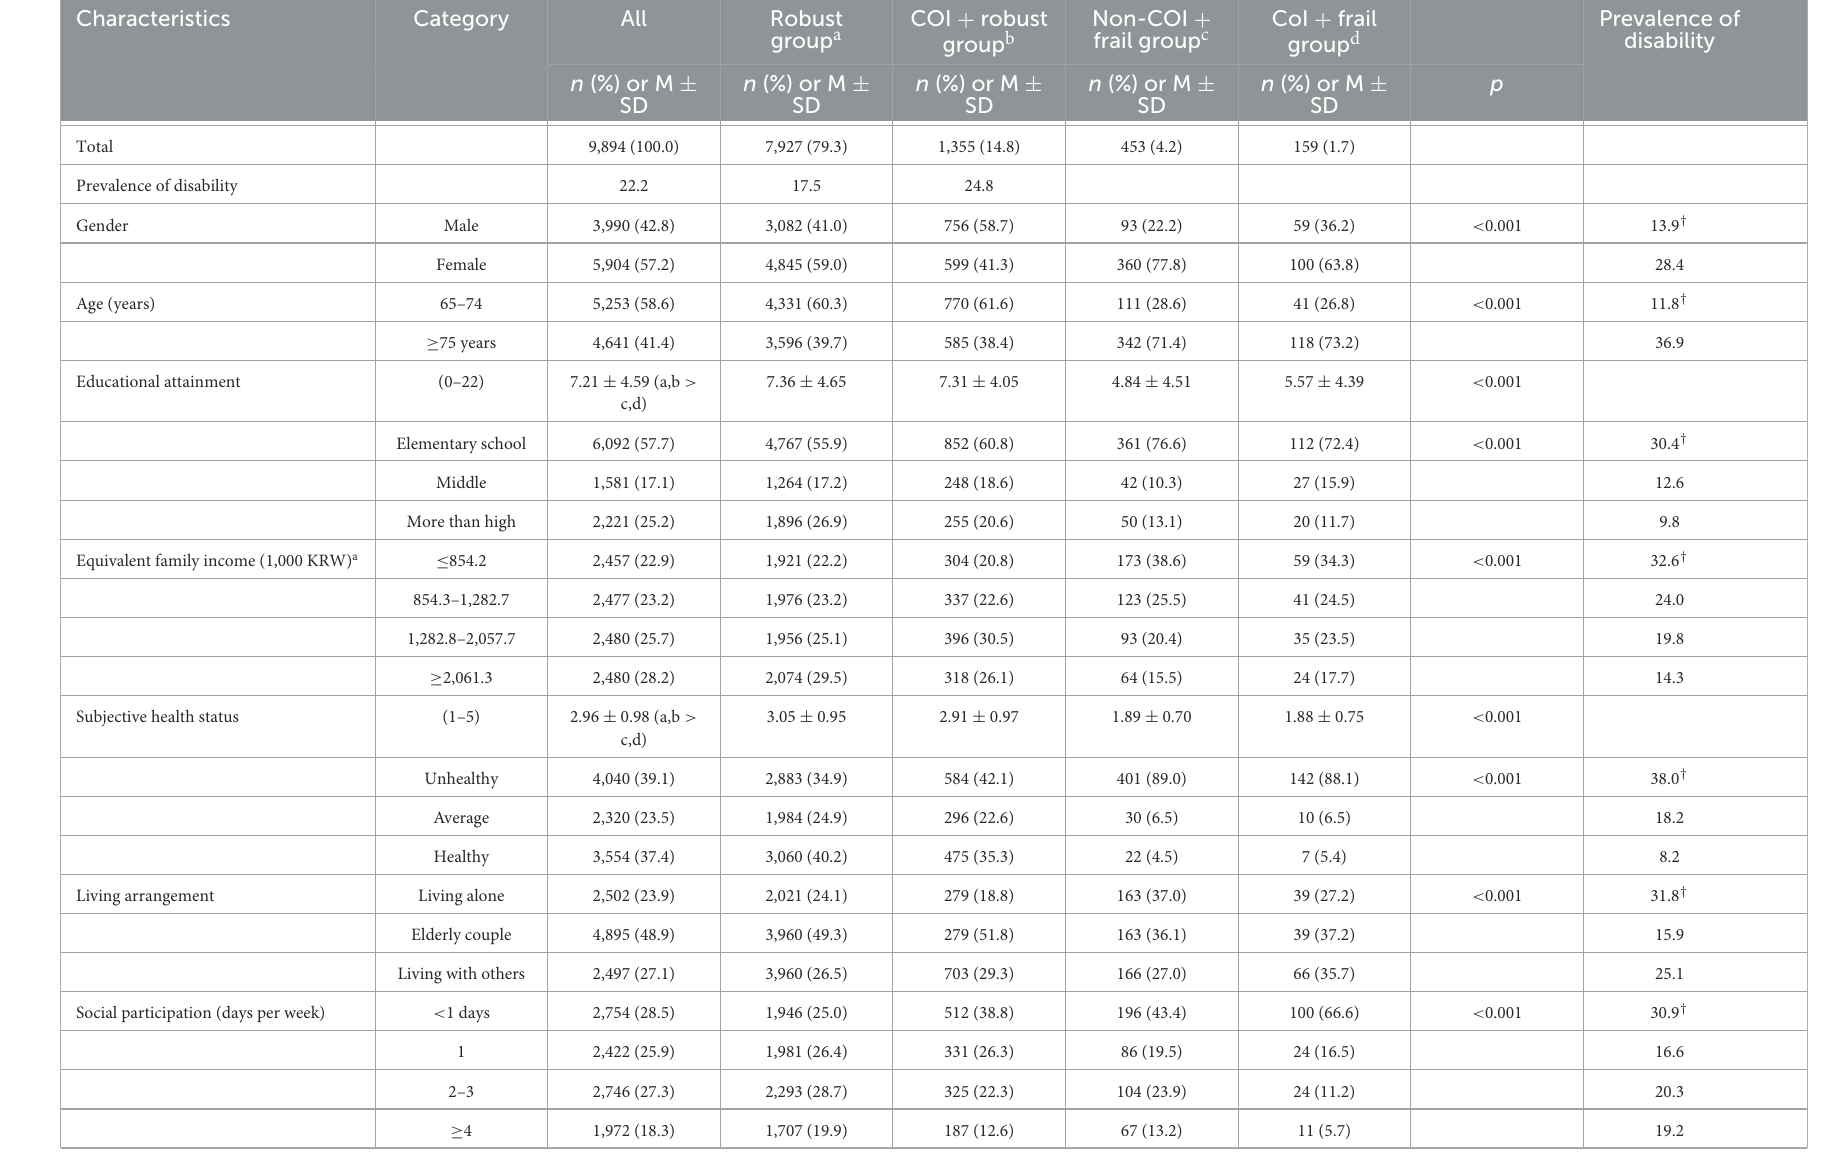
TABLE 1 General characteristics and social factors according to cognitive frailty groups and prevalence of disability ( N = 9,894). Characteristics Category All Robust